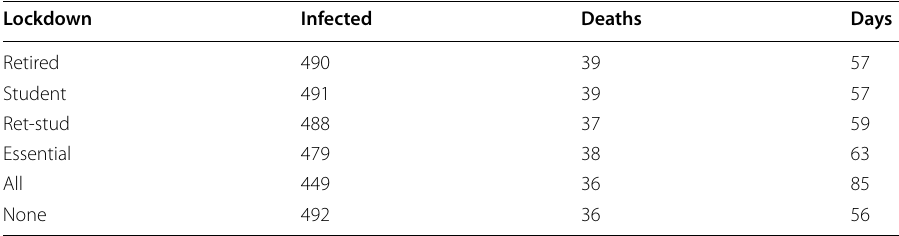
Table 6 Misinfodemic, no detection and no isolation Lockdown